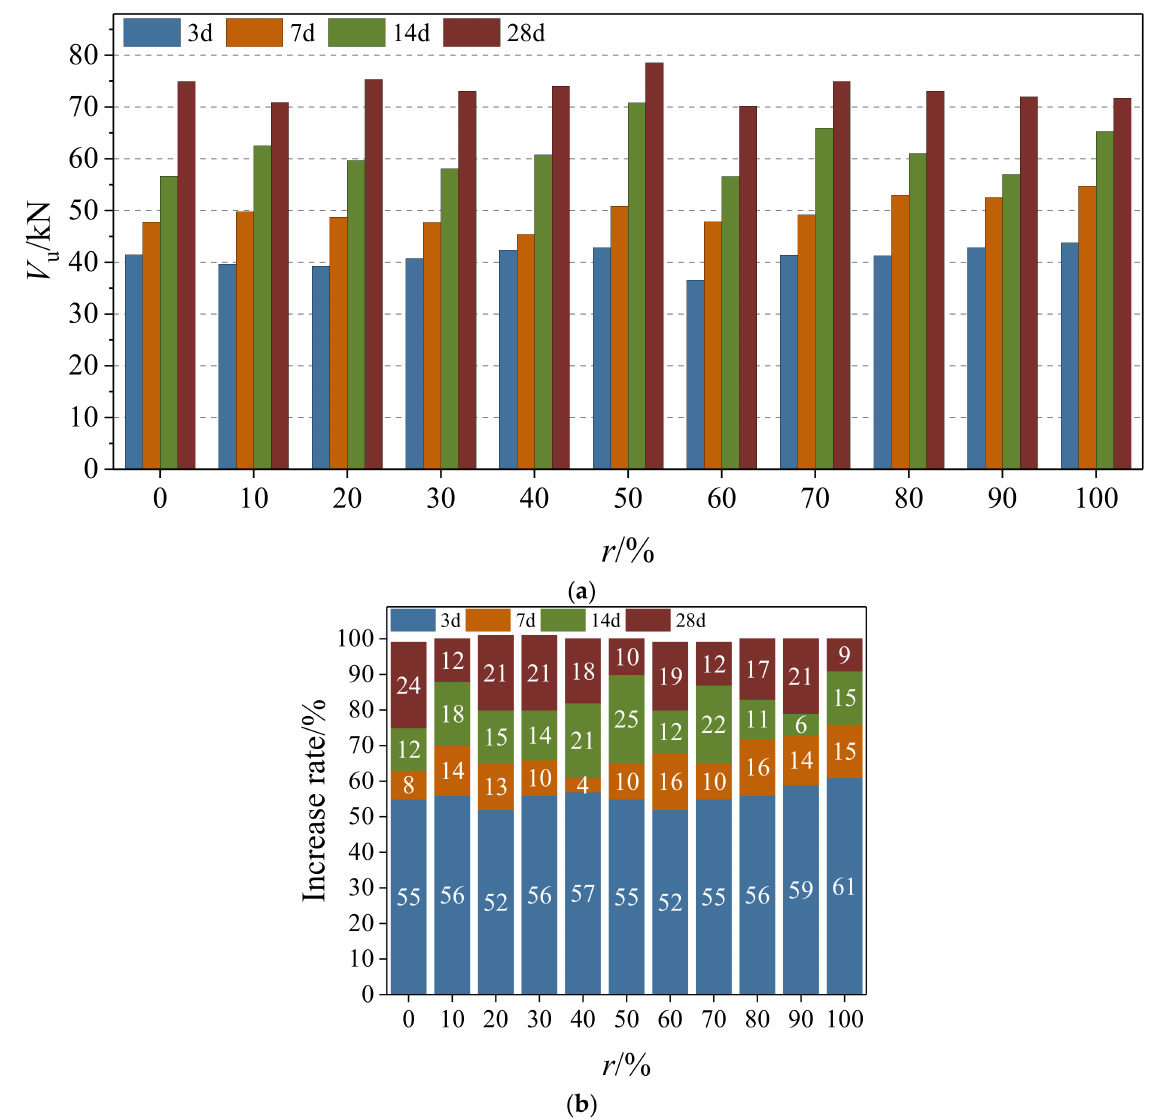
Figure 7. Comparison of peak shear force and increase rate of specimen: ( a ) comparison of peak shear force and ( b ) comparison of increase